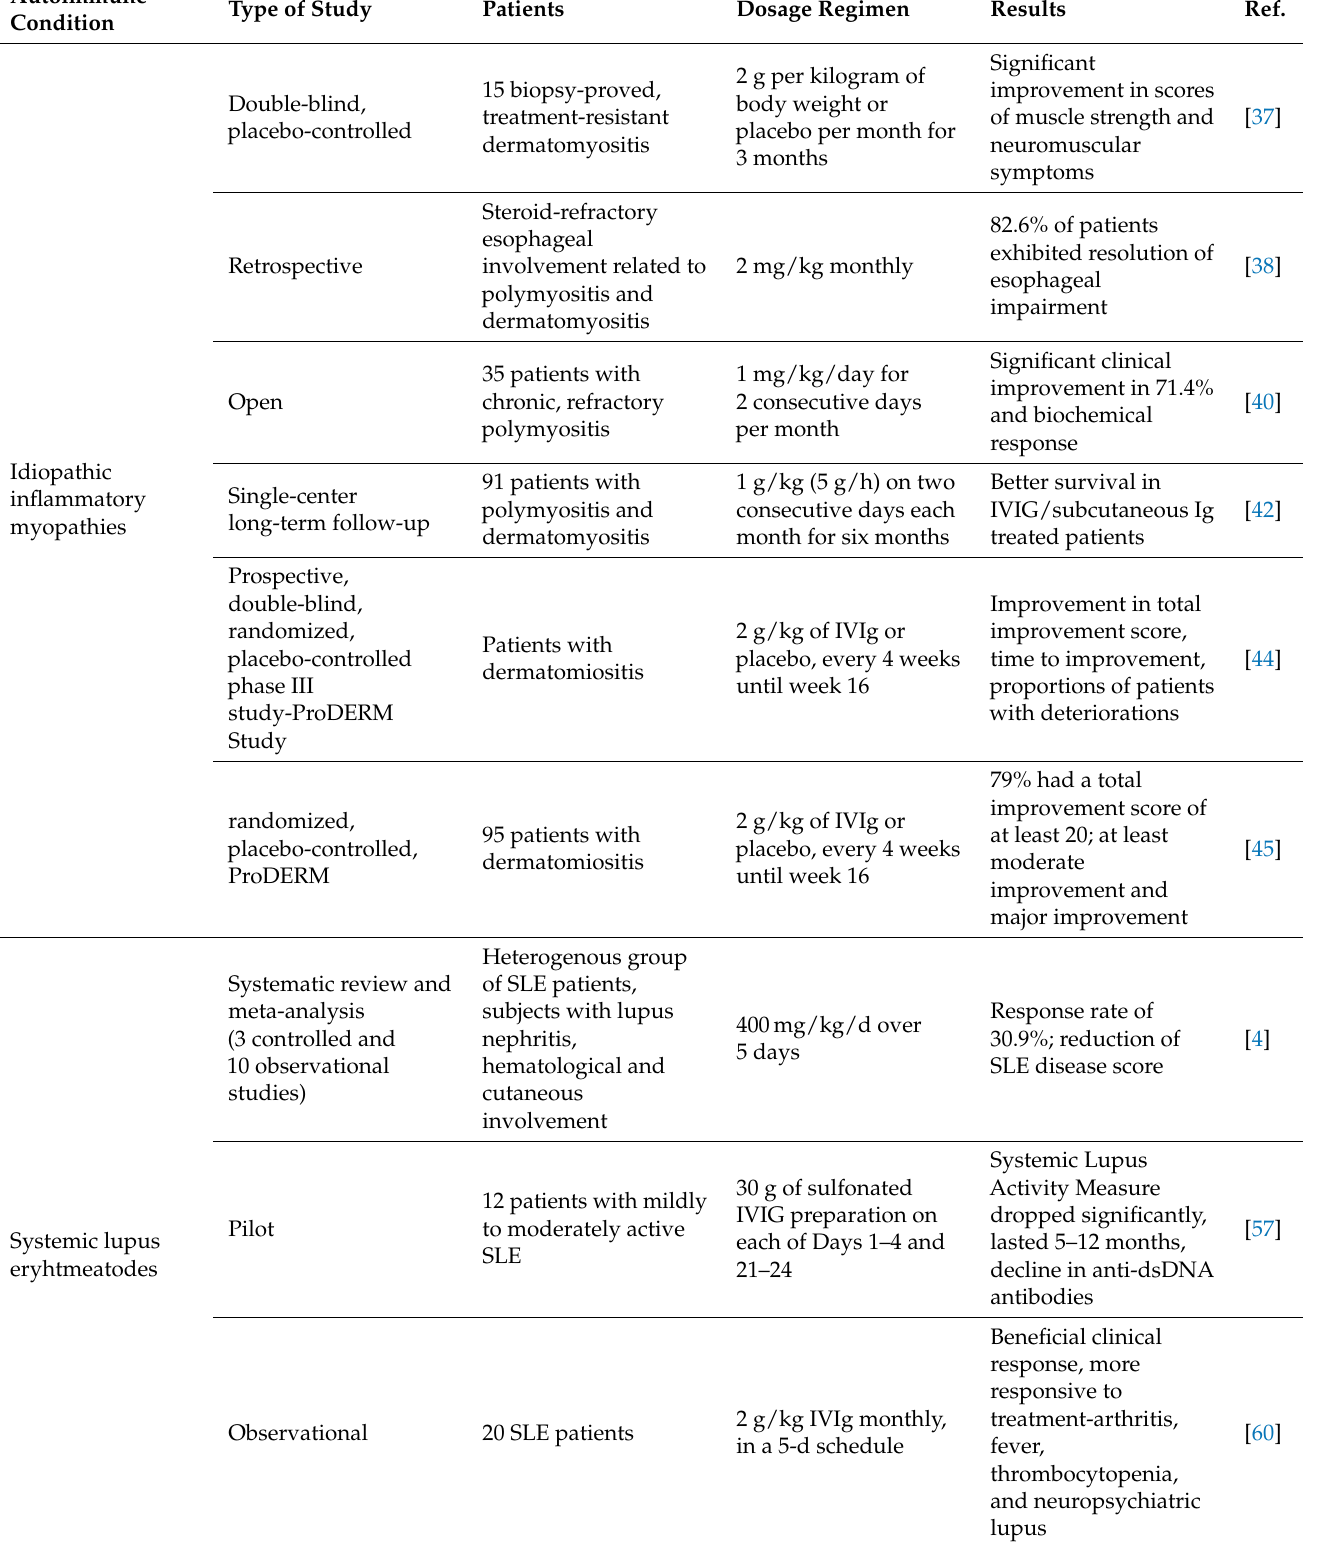
Table 1. Studies available on patients with autoimmune diseases, treated with